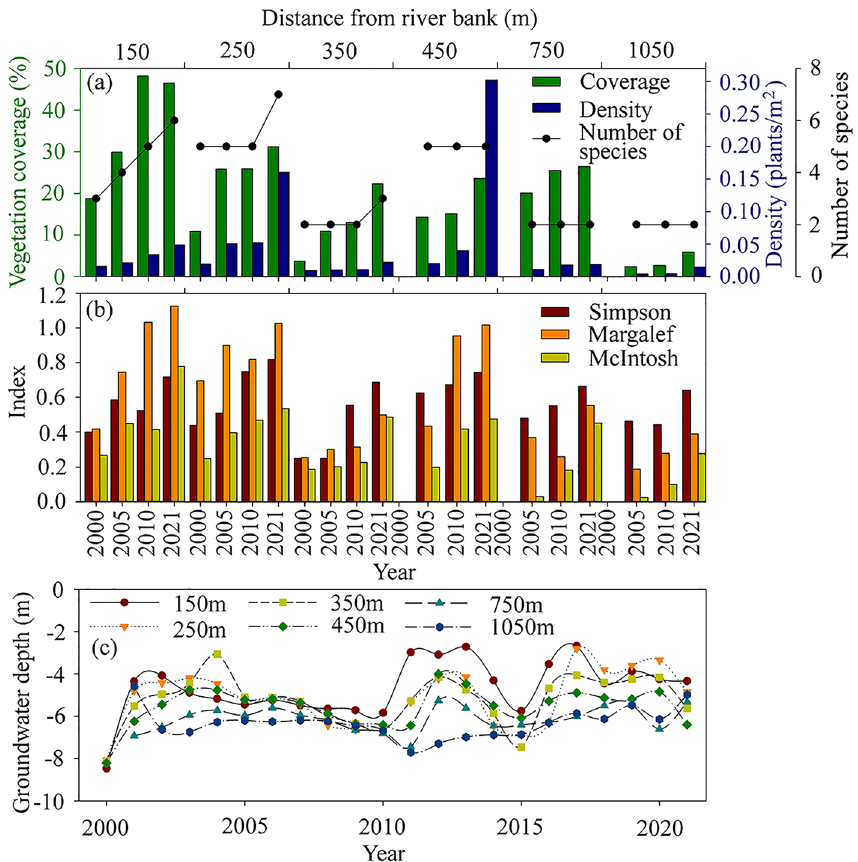
Figure 3. Changes in vegetation coverage, density and number of species ( a ), species diversity indices ( b ), and groundwater depth ( c ) for each site at Yengsu section in the lower reaches of Tarim